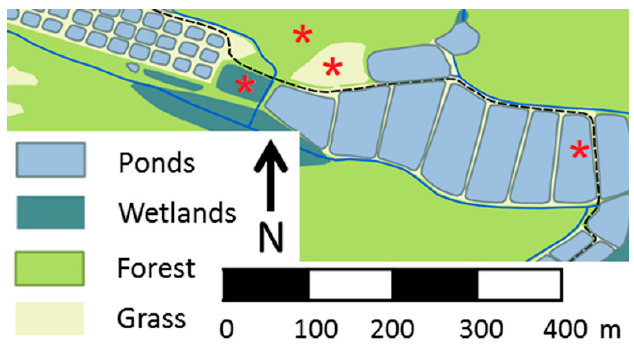
Figure 1. A map showing the proximity of the sampling locations (red stars) at the adjacent landscapes at the University of Mississippi Field Station.